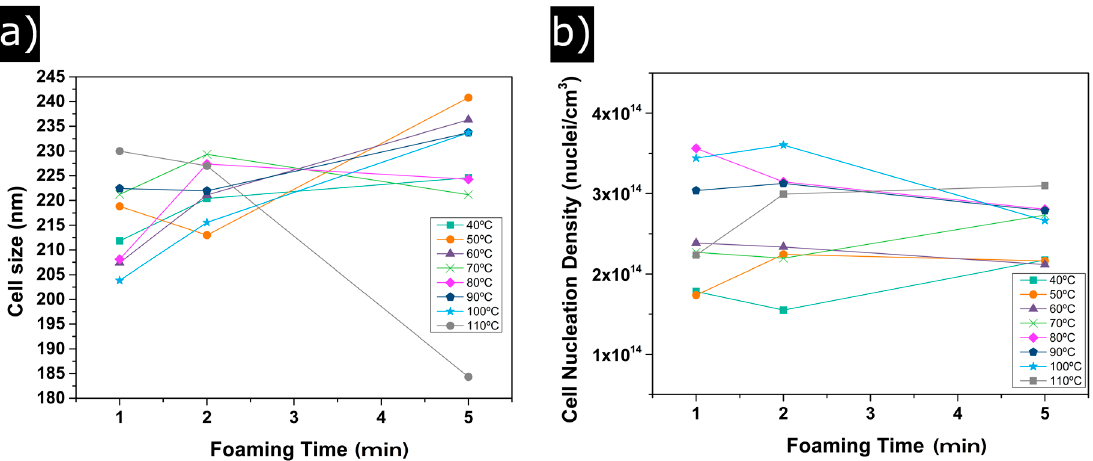
Figure 4. ( a ) evolution of the cell size with foaming time; ( b ) evolution of cell nucleation density with foaming time.